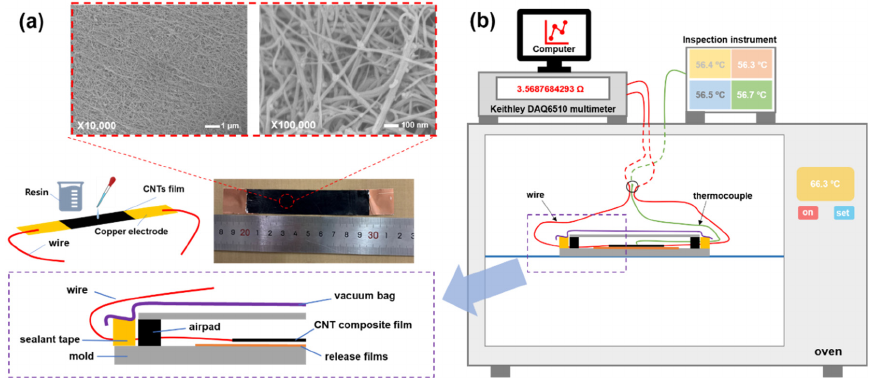
Figure 1. ( a ) The surface morphology of the pristine CNT film, and ( b ) a schematic of in situ monitoring of electrical resistance for CNT/epoxy composite films during curing process.